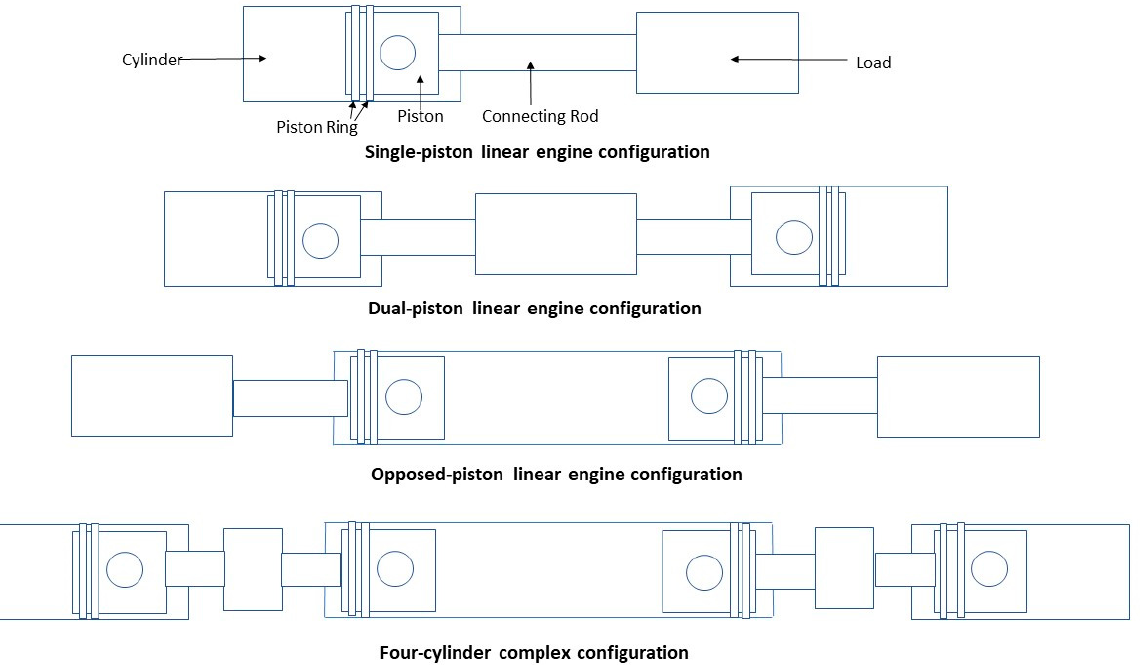
Figure 3. Different configurations of free-piston linear generator.